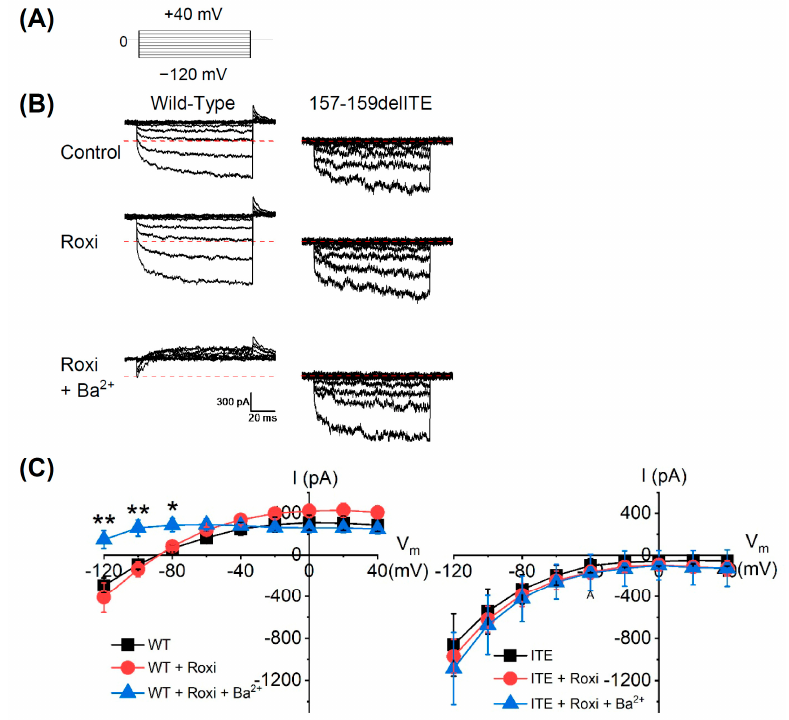
Figure 3. The electrophysiology experiments of KCNJ5 157-159delITE mutation. HEK293T cells expressing wild-type (WT) or KCNJ5 157-159delITE mutant (ITE) were whole-cell patched under voltage clamp mode with a holding potential of 0 mV. ( A ) The membrane potential stimulation profile. The membrane potentials were changes to various potentials with a step of 40 mV from − 120 mV and the currents were recorded. ( B ) The representative current traces from the same cells expressing WT (Left) and ITE (Right). The currents were recorded at 10 min after the formation of whole-cell patch (Control), 5 min after the serial addition of roxithromycin (20 µ M, Rox) and Ba 2+ (1 mM, Rox + Ba 2+ ). The red dash lines indicate the zero current. ( C ) The averages current–voltage relationship of cells expressing WT (Left) and ITE mutant (Right). The currents at the last 10-ms interval during the change of membrane potentials were averaged and plotted against the potentials. Data presented were Mean ± SEM; the sample number for WT and ITE were 5 and 6, respectively. * indicated p < 0.05 and ** indicated p <